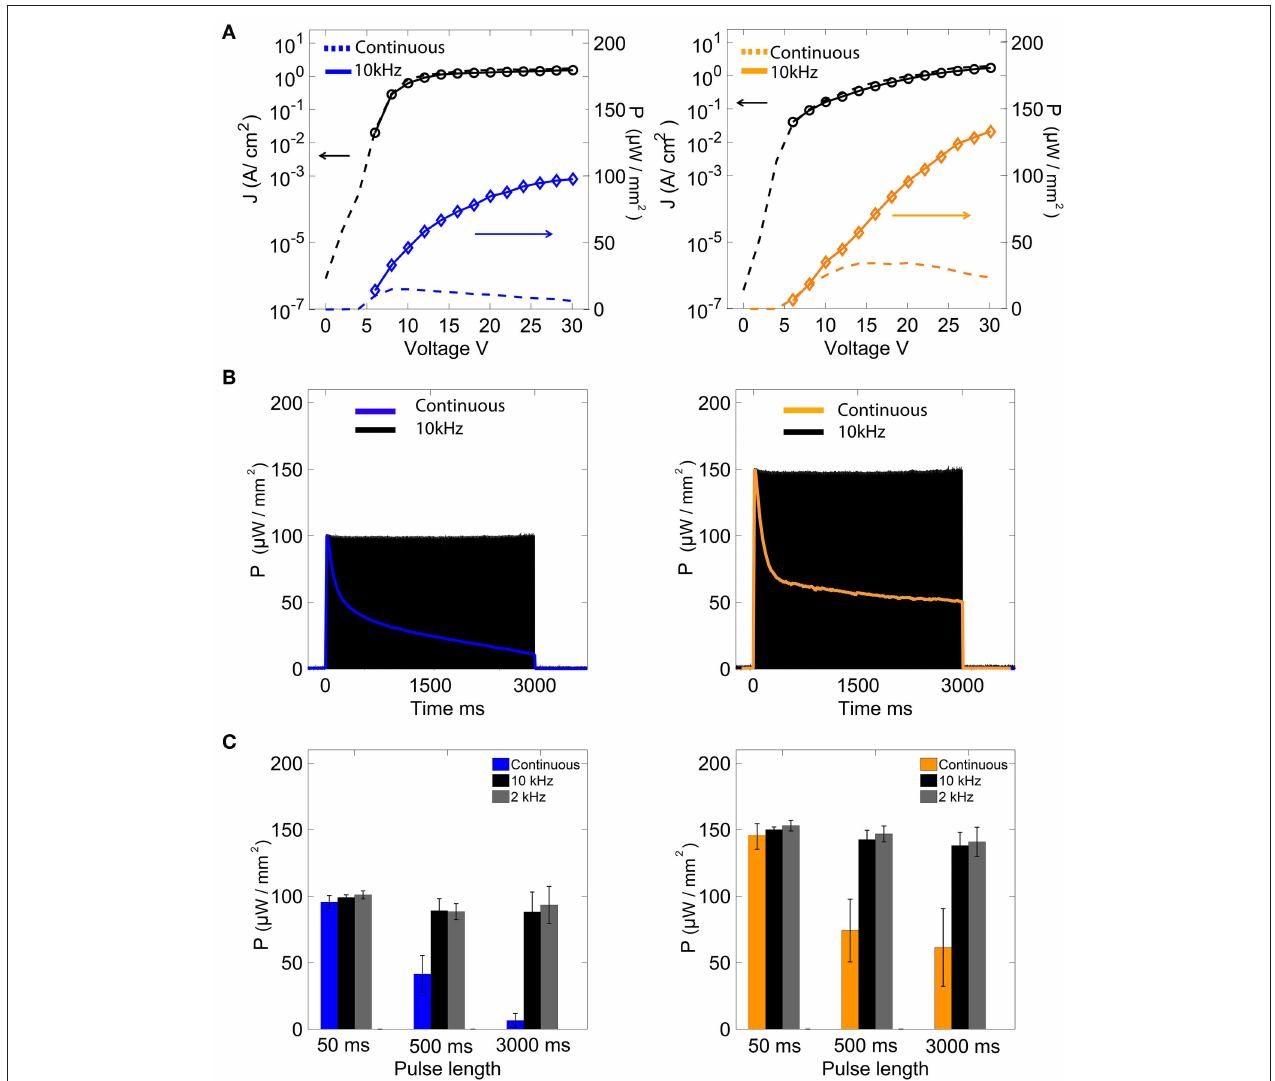
FIGURE 2 | Performance characteristics of blue and orange OLEDs. (A) Current-density and optical power vs. voltage characteristics for blue and orange devices under DC and 10kHz square-wave operation. (B) Optical output power vs. time for blue and orange OLEDs under DC and 10KHz square-wave operation. (C) Peak optical power (mean ± sem) under DC and square-wave operation for measurement times of varying